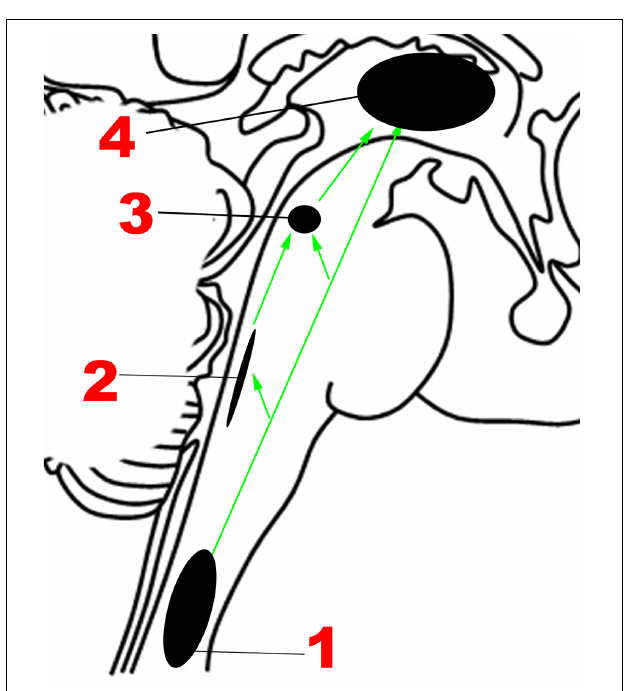
FIGURE 2 | Major structures involved in the Ascending network. (1) Spinothalamic tracts. (2) Nucleus of the tractus solitarius. (3) Parabrachial nuclear complex. (4) Thalamus. Green arrows: Ascending